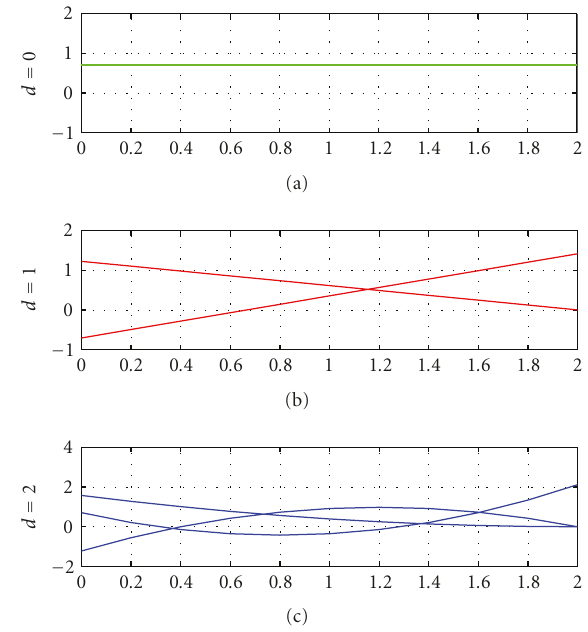
Figure 1: Orthonormal spline bases for d = 0, d = 1, and d =